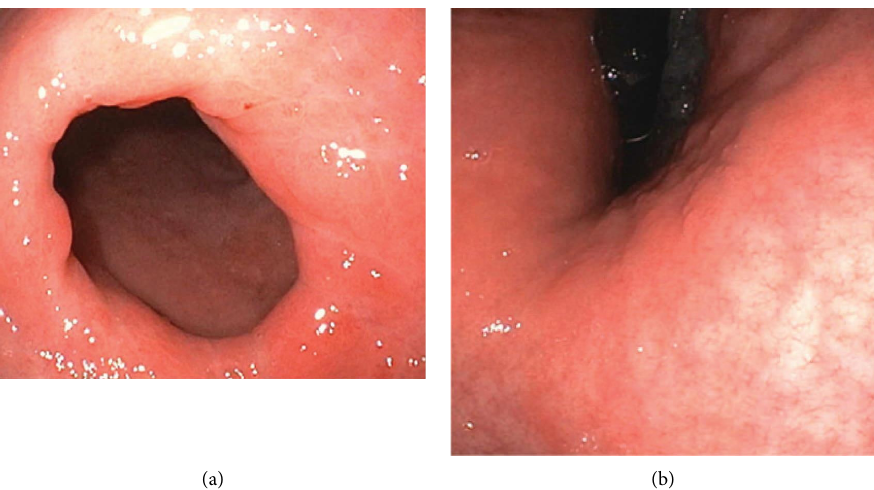
Figure 1: EGD/colonoscopies performed on the patients revealed hypertrophic gastric mucosa ((a) case 1, pylorus), as well as erythema, vascular congestion, and surface nodularity ((b) case 2, antrum).